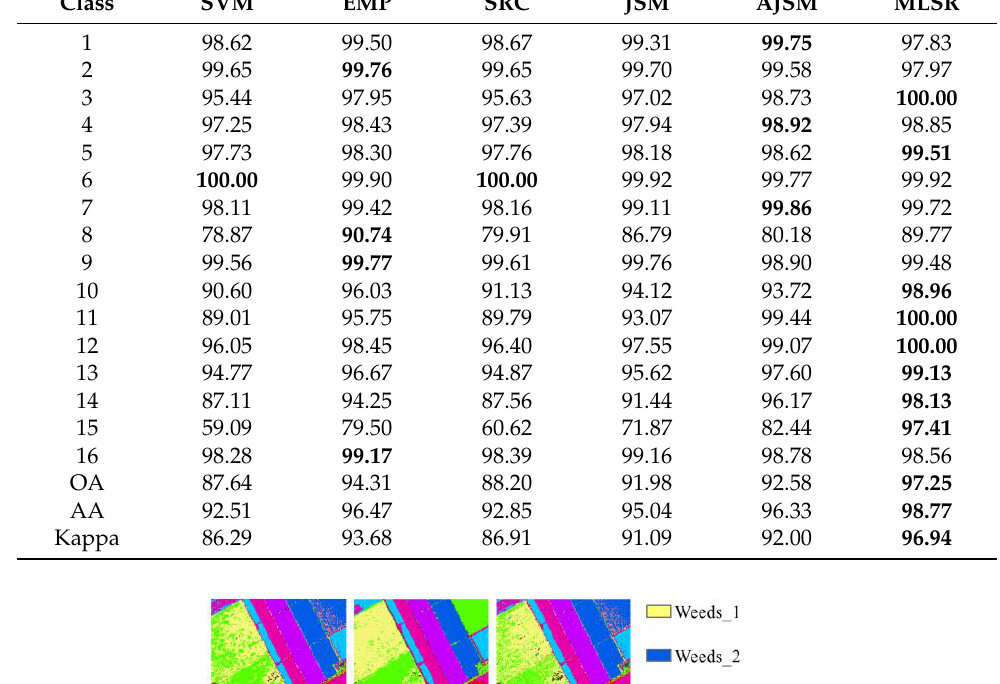
Table 6. Classification accuracies (%) for the Salinas image. The best results are shown in boldface.